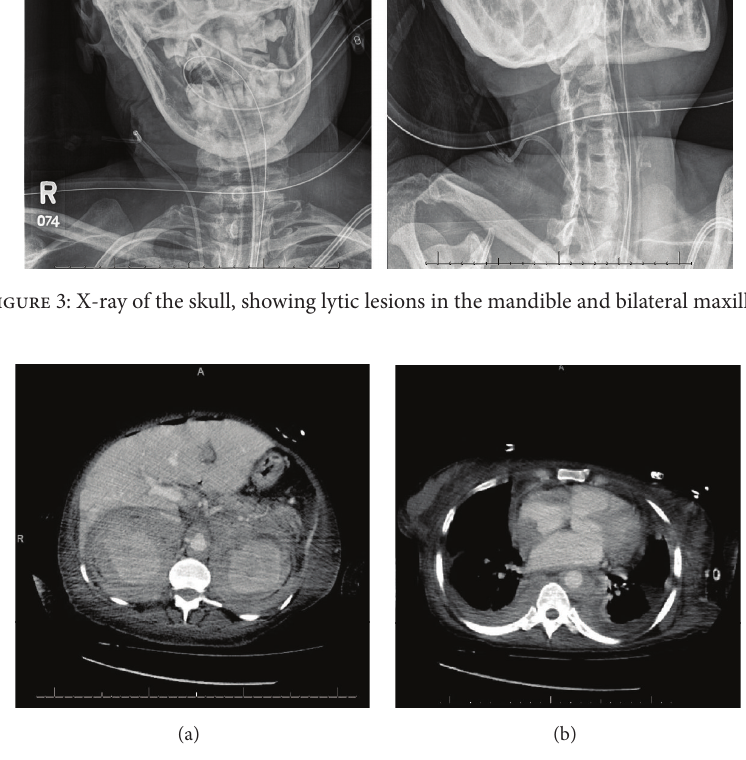
Figure 4: CT of the abdomen (a) showing extensive retroperitoneal soft tissue (fibrosis) surrounding the kidney and vessels. The soft tissue is seen extending into the mediastinum with involvement of the pleura, heart, and vessels